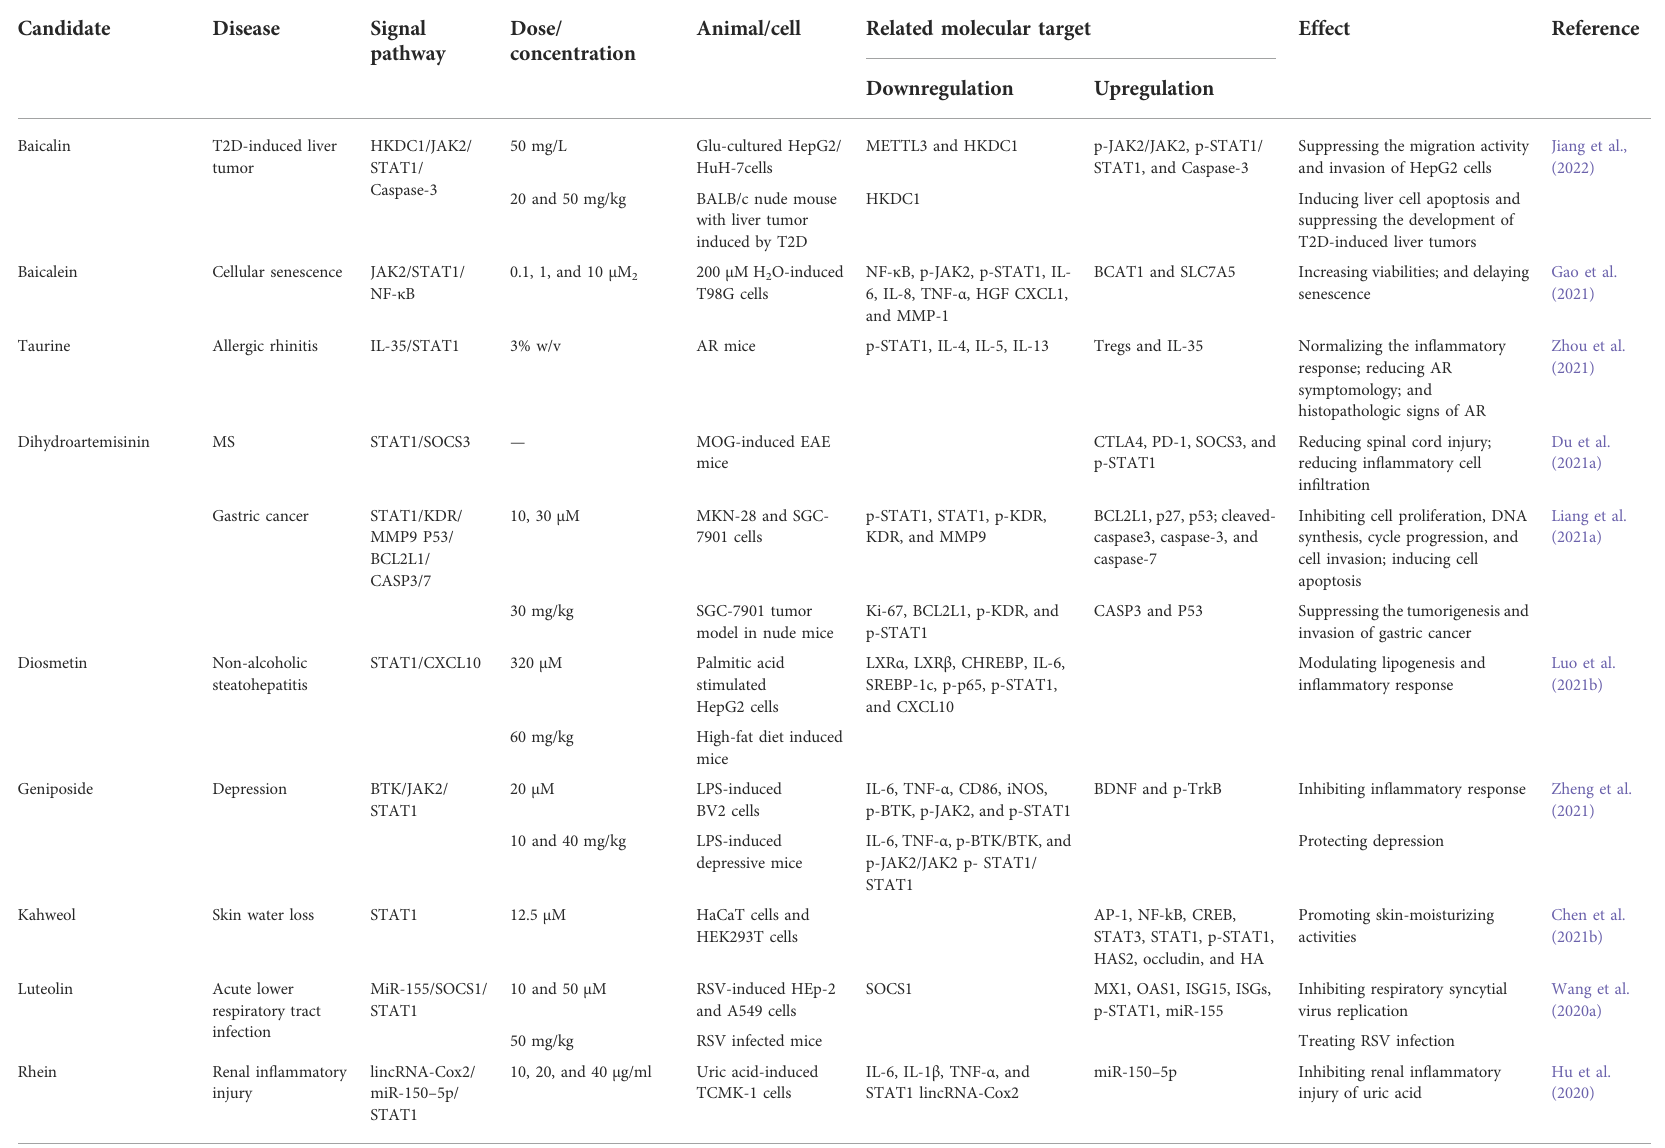
TABLE 1 Chinese herbs and herb formulas, natural compounds, and phytochemicals in the treatment of diseases through regulating